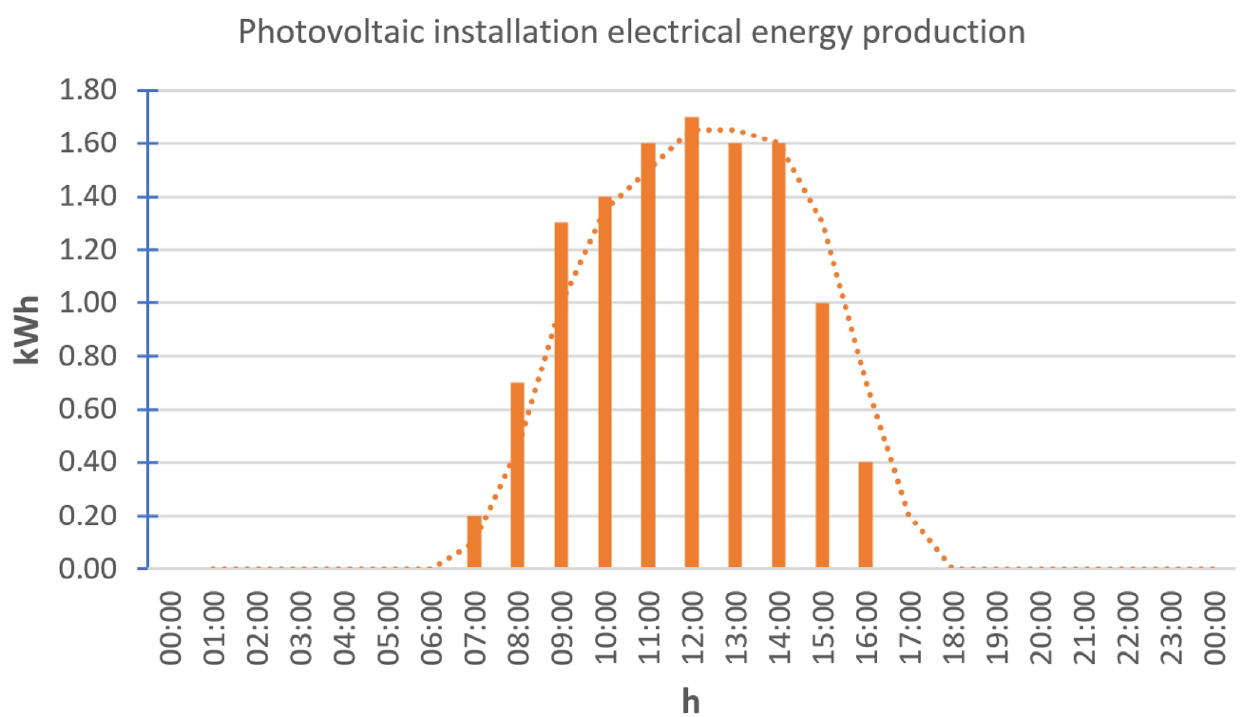
Figure 6. Biogas plant’s electrical energy production profile during a 24 h cycle for farmland with 20 cows. Own study based on source [55].